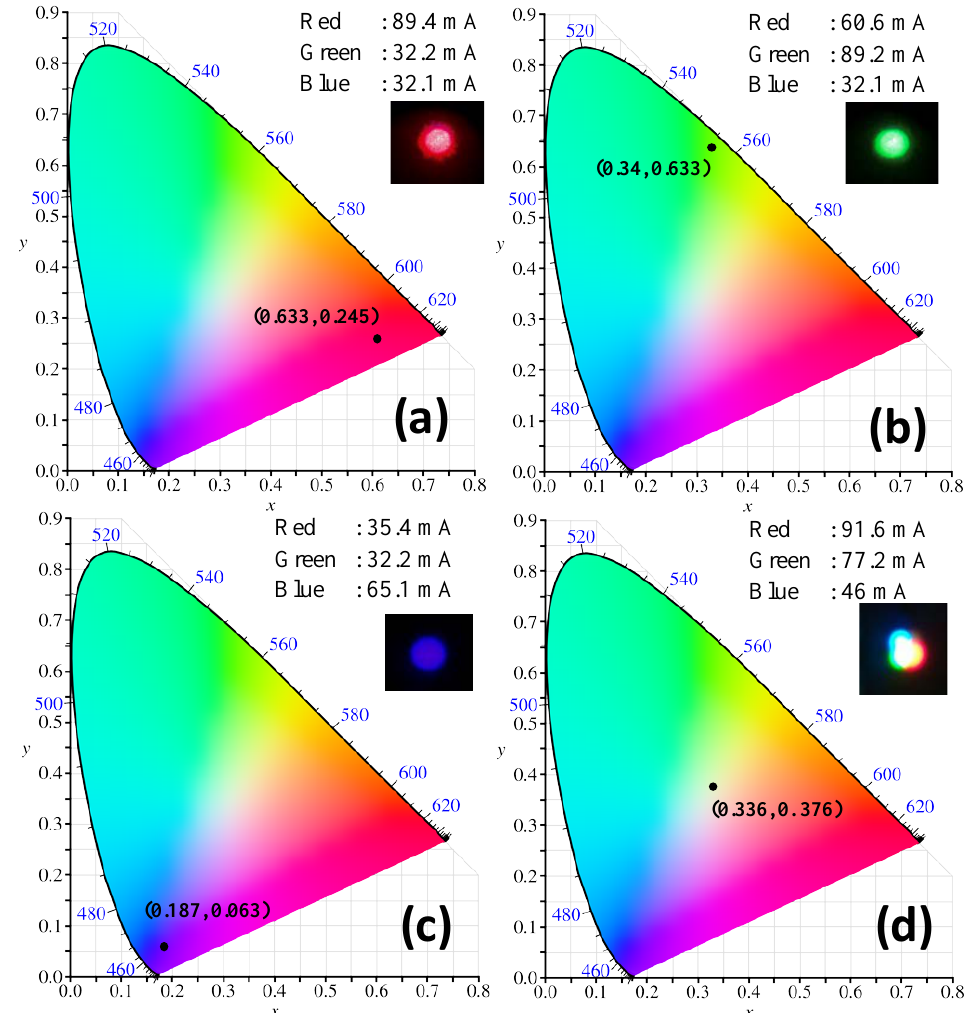
Figure 5. Experimentally measured CIE 1931 chromaticity color gamut at different driving currents for the RGB LDs respectively; showing colors of ( a ) red, ( b ) green, ( c ) blue and ( d ) white . Insets: photos of the color generated.